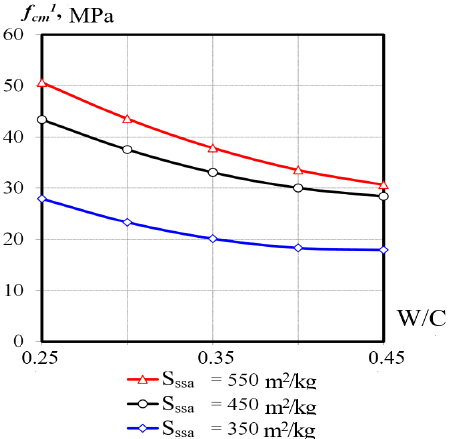
Figure 5. The influence of W/C and specific surface area on the concrete compressive strength at the 1 day (PFM 1 = 0.7%).